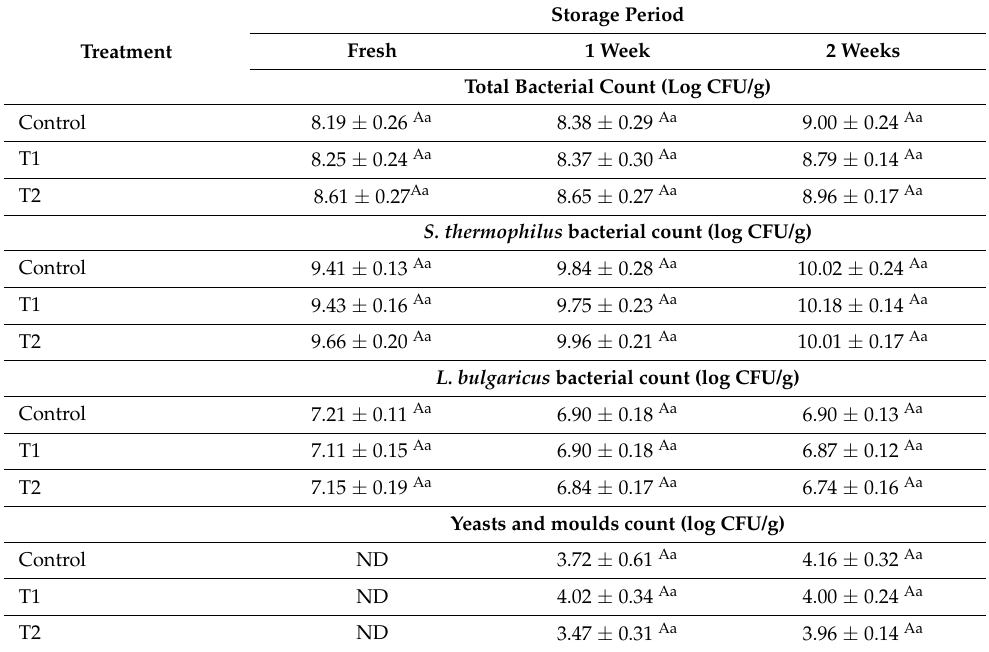
Table 1. The effect of adding different concentrations of chromium (CrPi) on the microbial composi- tion of yoghurt during storage.